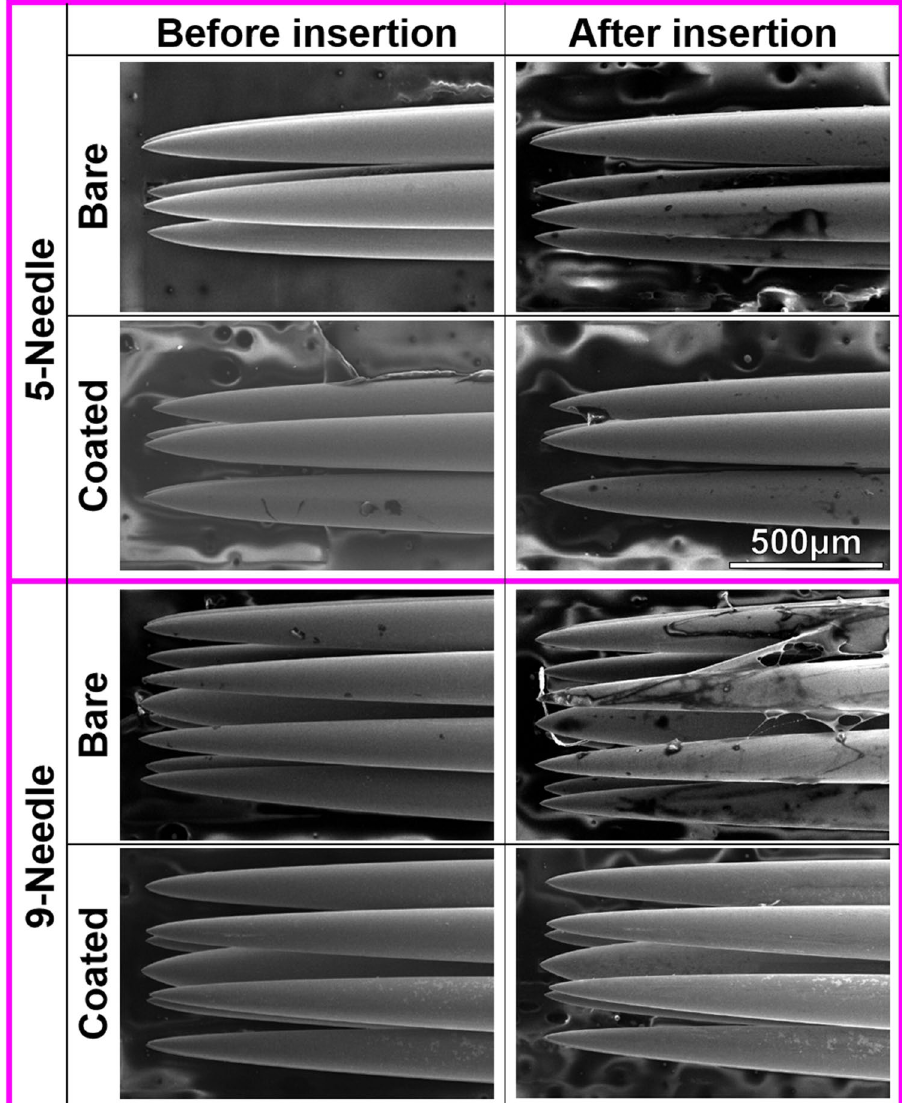
Figure 5. SEM images of bare and coated needles before and after 30-time insertion tests on the pork